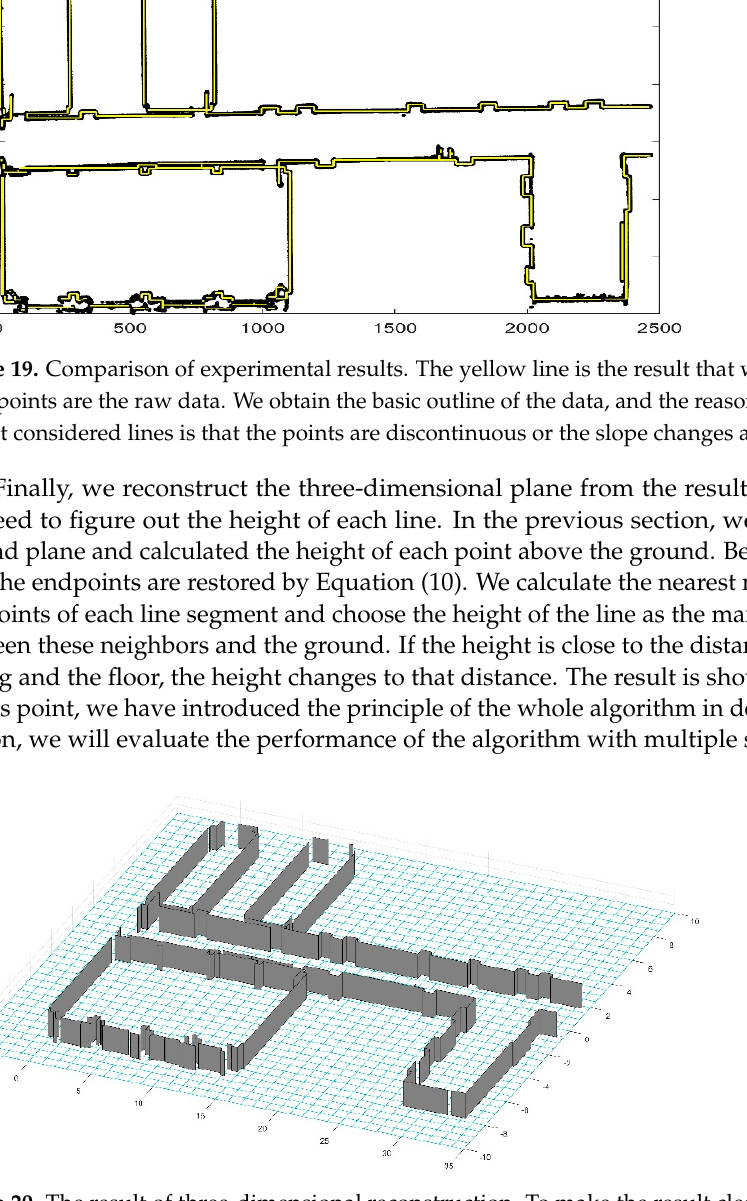
Figure 20. The result of three-dimensional reconstruction. To make the result clearer, we removed the ceiling and painted all the vertical planes on the ground.